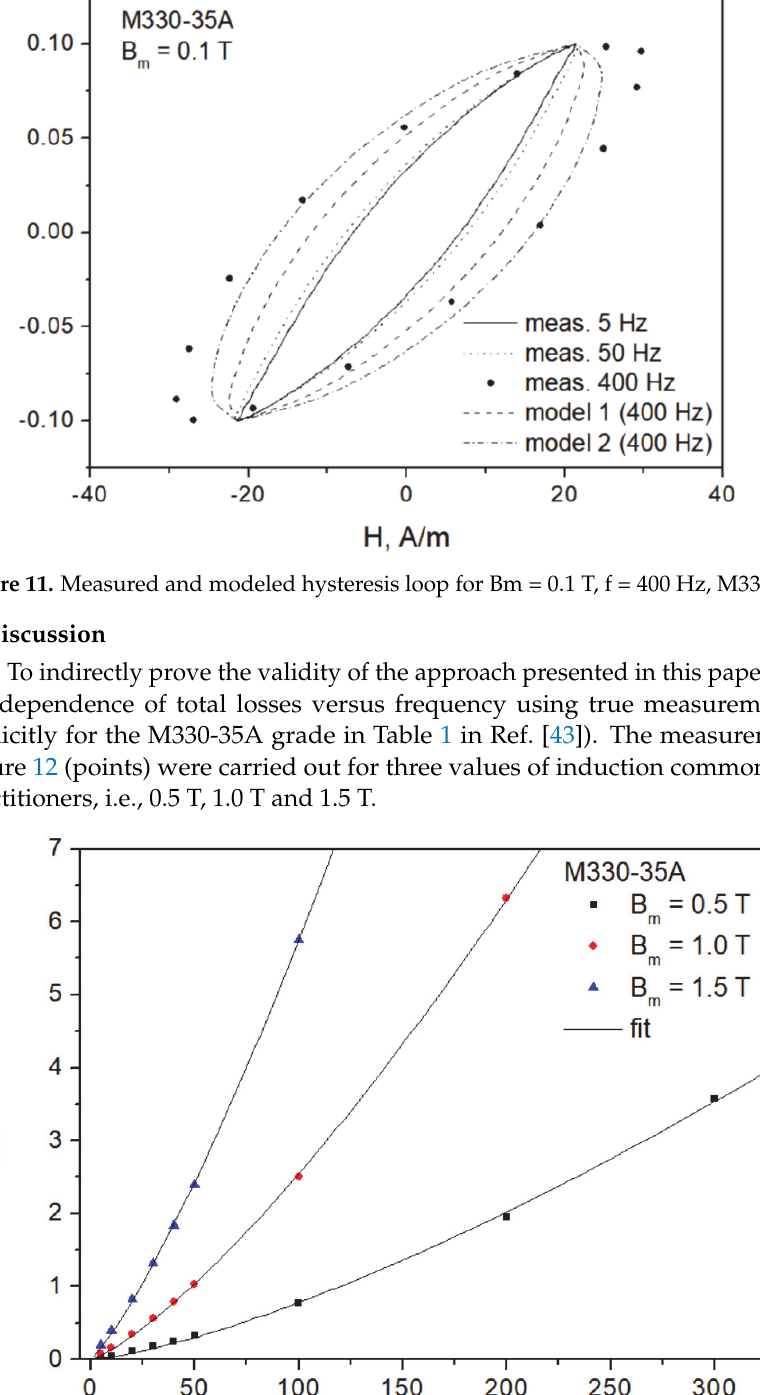
Figure 10. Measured and modeled hysteresis loop for Bm = 1.5 T, f = 50 Hz, M330 ‐ 35A grade.